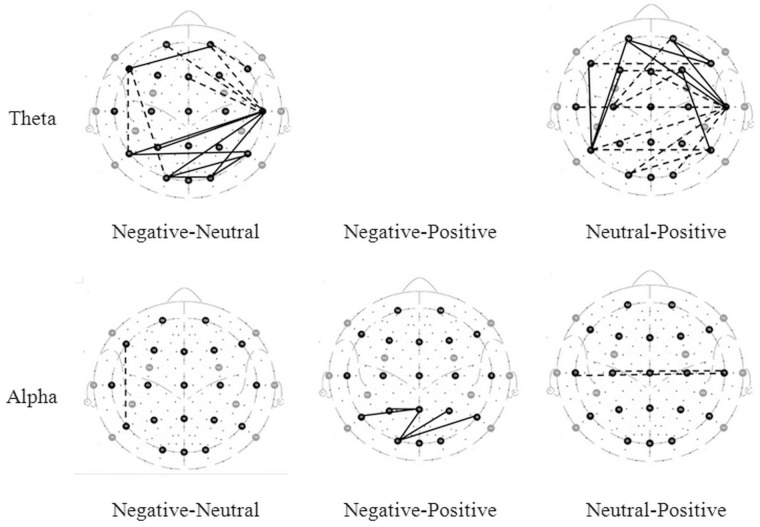
Brain maps of correlation.The lines connecting electrode sites indicate significant higher (solid) and lower (dashed) of correlation values for condition listed on left site.